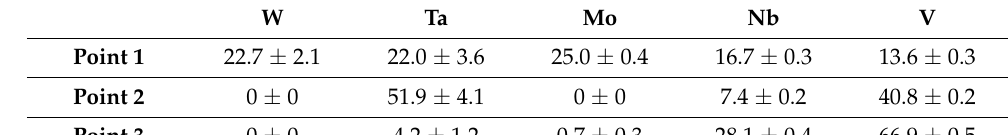
Figure 5. Microstructure by SEM backscattered electron mode of HEA WTaMoNbV produced by Table 7. Local chemical compositions (at. %) by EDS analysis; related to Figure 5c.